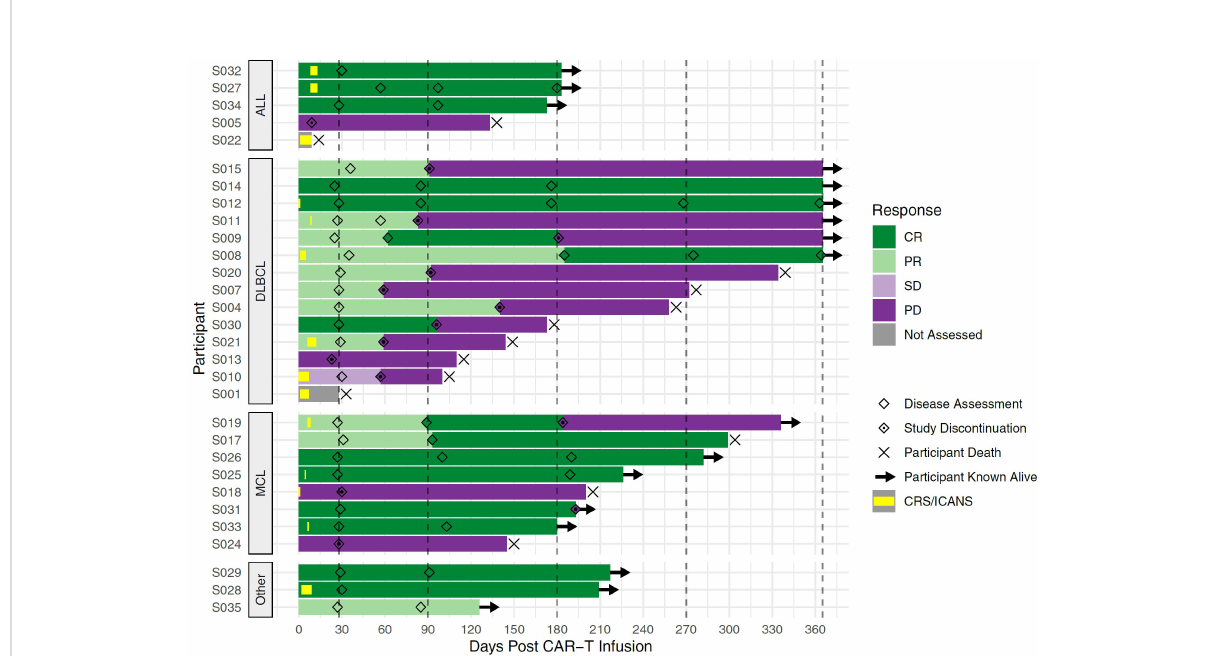
FIGURE 6 Swimmer ’ s Plot of Patient-level Data. Each bar represents one CLIC-01 participant infused with CLIC-1901. Participants are grouped into disease type (ALL, DLBCL, MCL, and Other). X-axis denotes the days after CAR-T infusion. Vertical dashed lines mark expected disease assessment time points. Hollow diamonds indicate the days where a disease assessment was made for each participant. Bars are coloured according to the response at each disease assessment, with the time between 2 assessments being coloured by the earlier assessment time. For the time before the fi rst assessment, bars are coloured by the response observed at the fi rst assessment. Periods of CRS or neurotoxicity are denoted by yellow bars within the overall bar. An × marks the death of a participant, and → denotes the patient is still known to be alive at that time point. For this fi gure, follow up is truncated at 1